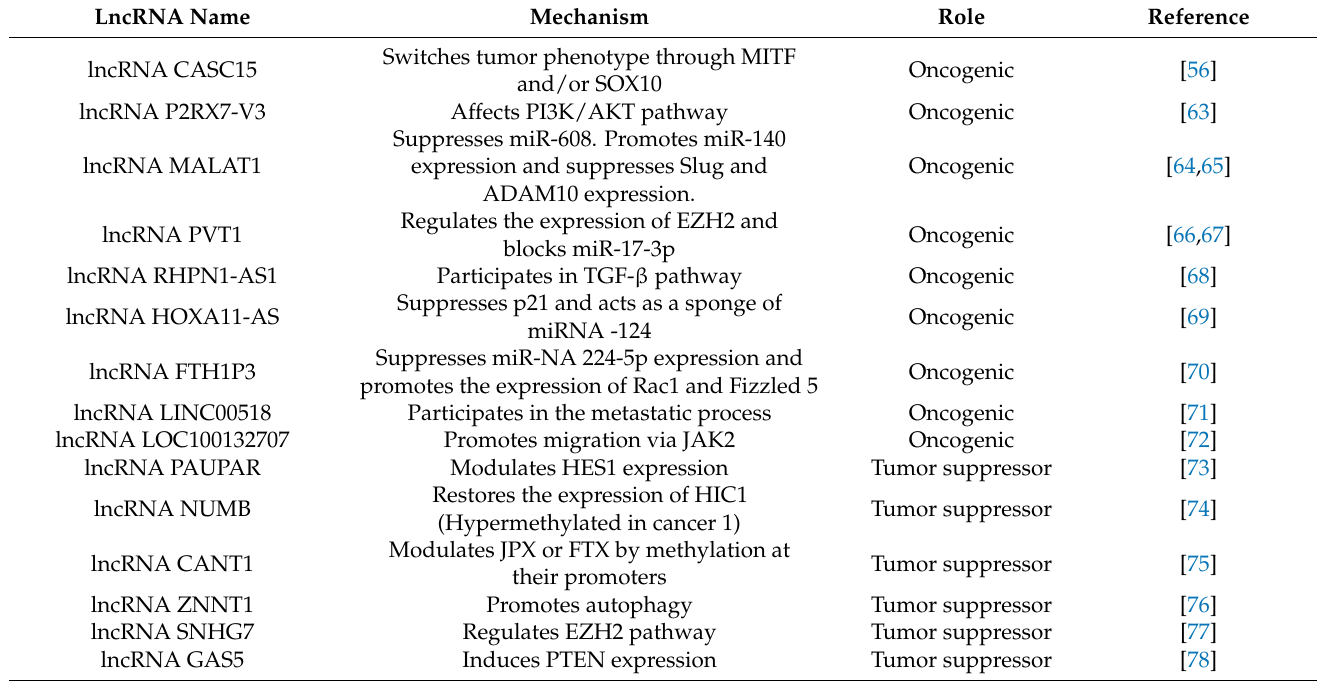
Table 2. LncRNAs implicated in UM